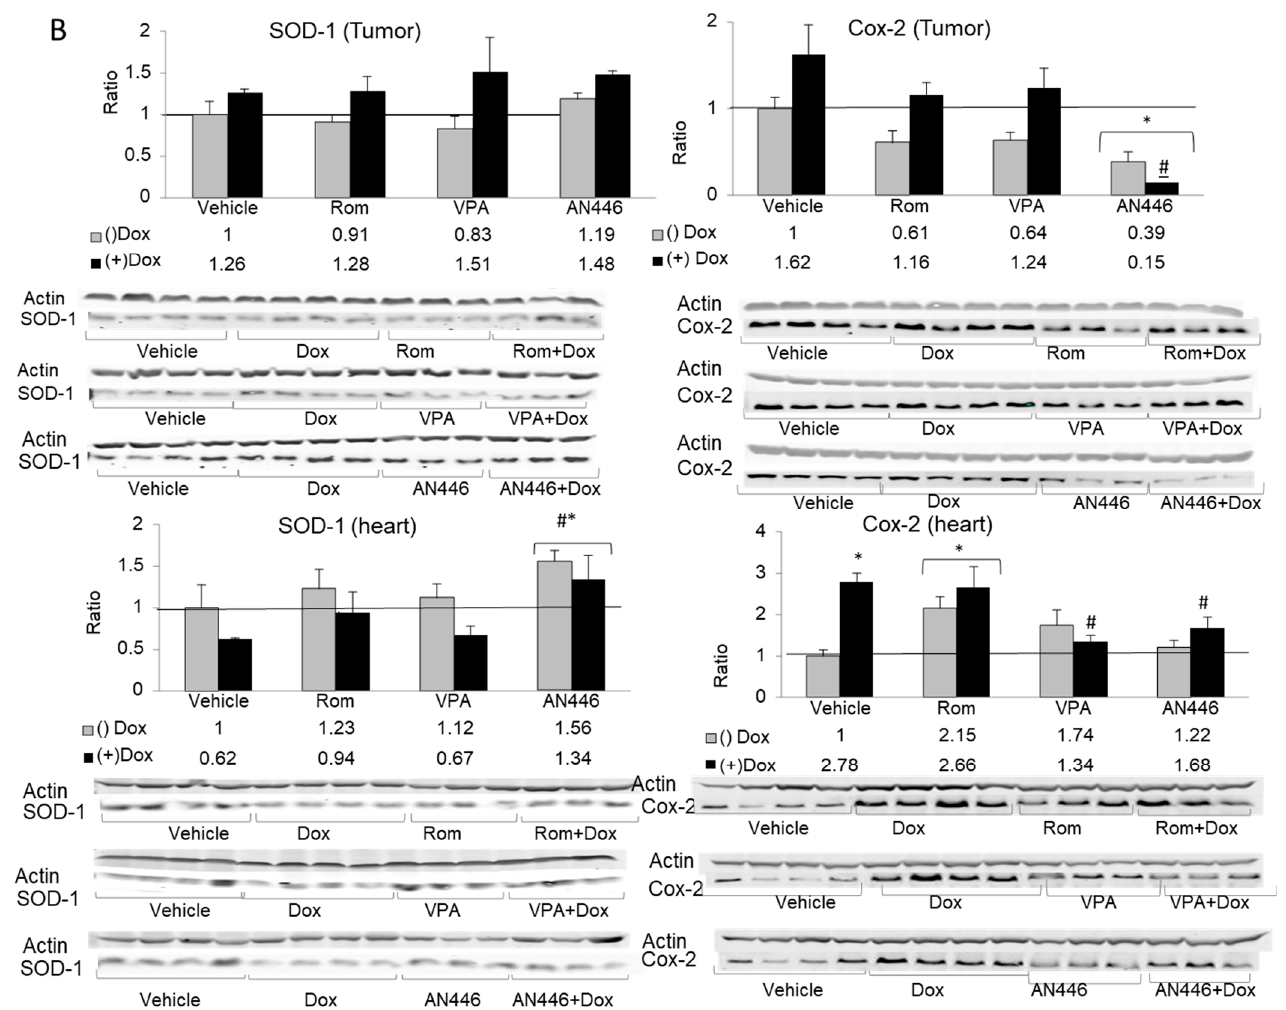
Figure 5. Effect of treatment with HDACIs, Dox, and their combination on protein expression in the tumors and the hearts of mice bearing 4T1 breast cancer. For the detection of the specified proteins, samples were resolved on SDS gels by Western blot analysis. Lysates of tumors ( n = 3–4) (20 µ g protein) or hearts ( n = 3–4) (30 µ g protein) were loaded on the gels and subjected to the analyses using the specific antibodies for the detection c-Myc ( left -hand side) and SIRT 1 ( right -hand side), resolved on 10% SDS gel ( A ); detection of SOD1 ( left -hand side) and COX2 ( right -hand side) resolved on 12% SDS gel ( B ); fold increase represents the ratio of band intensity (mean ± SE) of drug-treated to vehicle-treated, each normalized to actin signal, * p < 0.05 all drug-treated vs. vehicle-treated mice; # p < 0.05 Dox-treated vs. drug-treated mice.